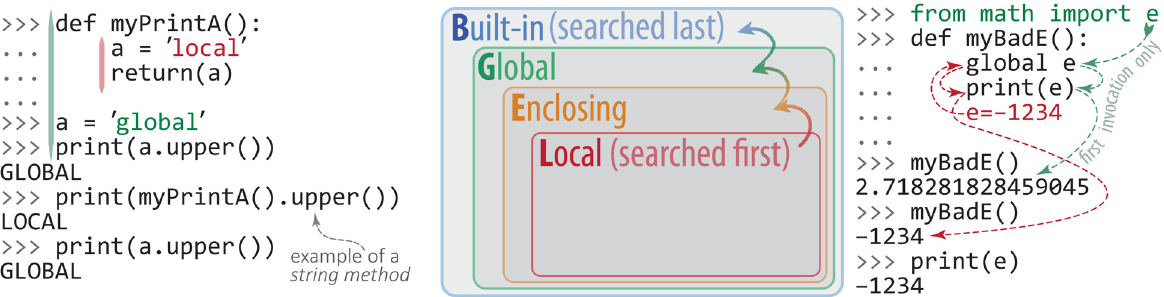
Fig 2. Python ’ s scope hierarchy and variable name resolution. As described in the text, multiple names (variables) can reference a single object. Conversely, can a single variable, say x , reference multiple objects in a unique and well-defined manner? Exactly this is enabled by the concept of a namespace , which can be viewed as the set of all name $ object mappings for all variable names and objects at a particular “ level ” in a program. This is a crucial concept, as everything in Python is an object. The key idea is that name $ object mappings are insulated from one another, and therefore free to vary, at different “ levels ” in a program — e.g., x might refer to object obj2 in a block of code buried (many indentation levels deep) within a program, whereas the same variable name x may reference an entirely different object, obj1 , when it appears as a top-level (module-level) name de fi nition. This seeming ambiguity is resolved by the notion of variable scope. The term scope refers to the level in the namespace hierarchy that is searched for name $ object mappings; different mappings can exist in different scopes, thus avoiding potential name collisions. At a speci fi c point in a block of code, in what order does Python search the namespace levels? (And, which of the potentially multiple name $ object mappings takes precedence?) Python resolves variable names by traversing scope in the order L ! E ! G ! B , as shown here. L stands for the l ocal, innermost scope, which contains local names and is searched fi rst; E follows, and is the scope of any e nclosing functions; next is G , which is the namespace of all g lobal names in the currently loaded modules; fi nally, the outermost scope B , which consists of Python ’ s b uilt-in names (e.g., int ), is searched last. The two code examples in this fi gure demonstrate variable name resolution at local and global scope levels. In the code on the right-hand side, the variable e is used both (i) as a name imported from the math module (global scope) and (ii) as a name that is local to a function body, albeit with the global keyword prior to being assigned to the integer -1234 . This construct leads to a confusing fl ow of logic (colored arrows), and is considered poor programming